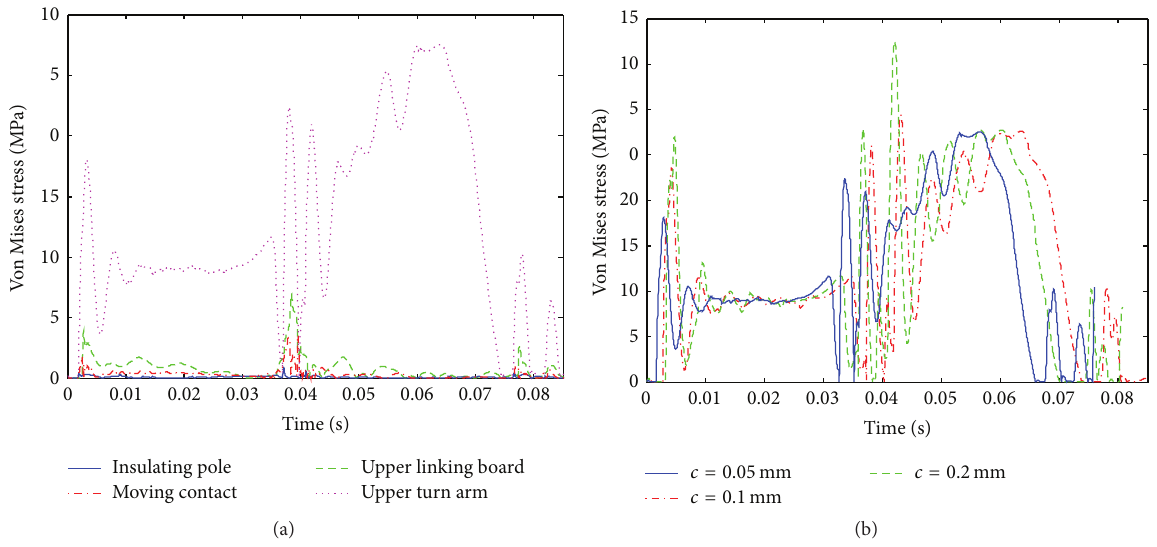
Figure 16: Dynamic stress for different clearance sizes: (a) Von Mises stress of the components and (b) Von Mises stress of upper turn arm.